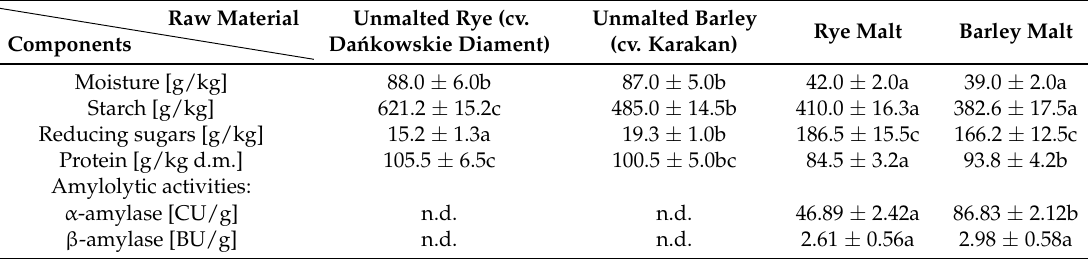
Table 1. Chemical composition of raw